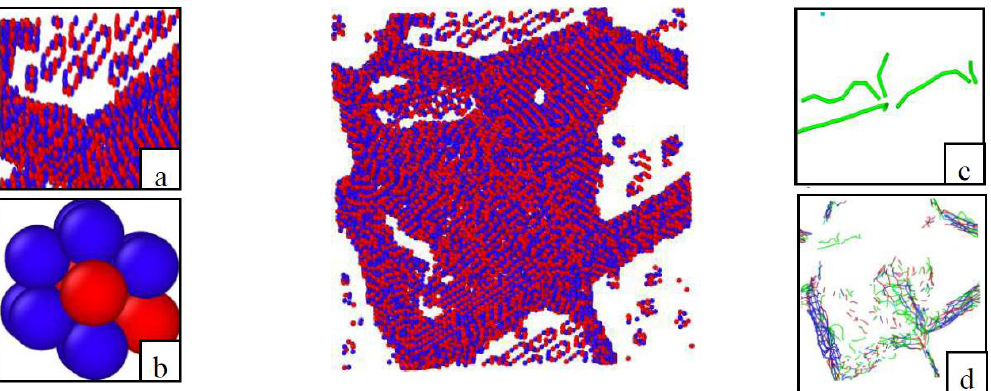
Figure 6. Microdefects in the initial model after prepressing: ( a ) the atom clusters in the clusters’ grains; ( b ) a Ti anti-site point defect (blue atoms are the Ti atoms, red atoms are the Al atoms); ( c ) the dislocations at the atom clusters; ( d ) the dislocations at the grain boundaries.